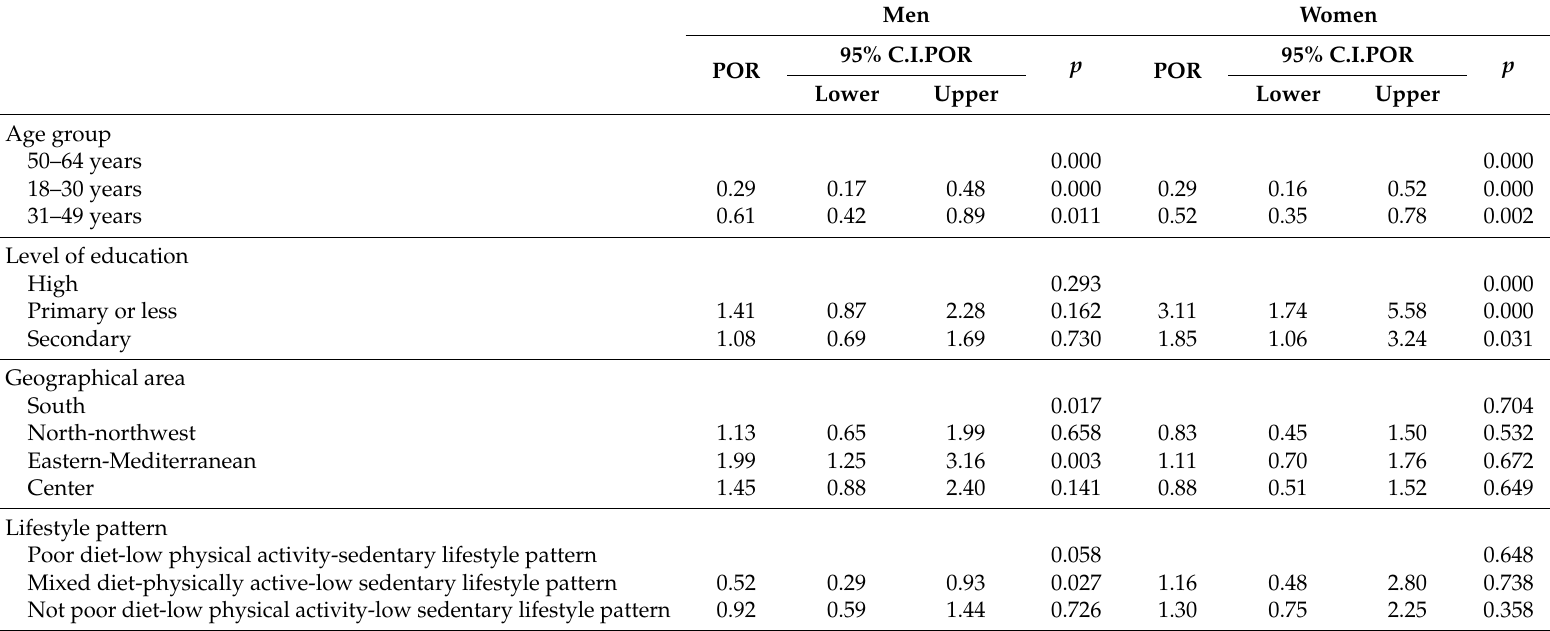
Table 4. Prevalence odds ratios (POR) of obesity in men and women, according to age group, level of education, geographical area, and lifestyle pattern.